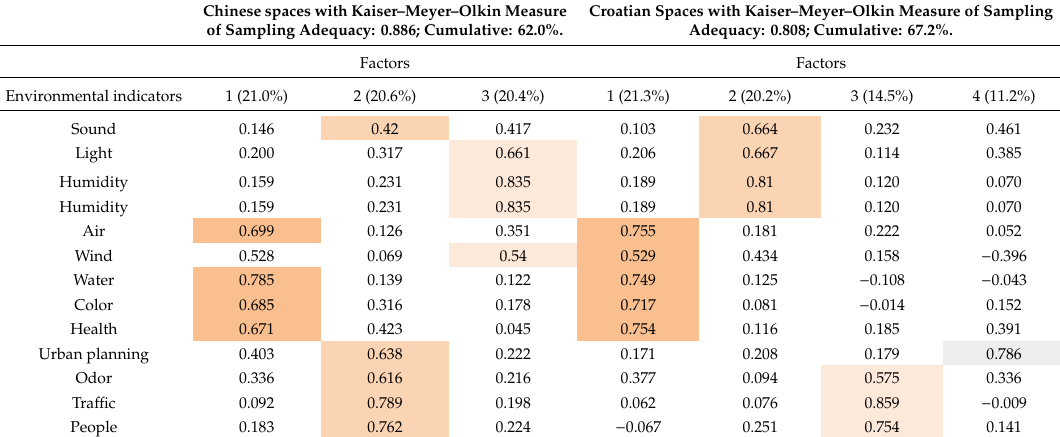
Table 4. Factor analysis of environmental